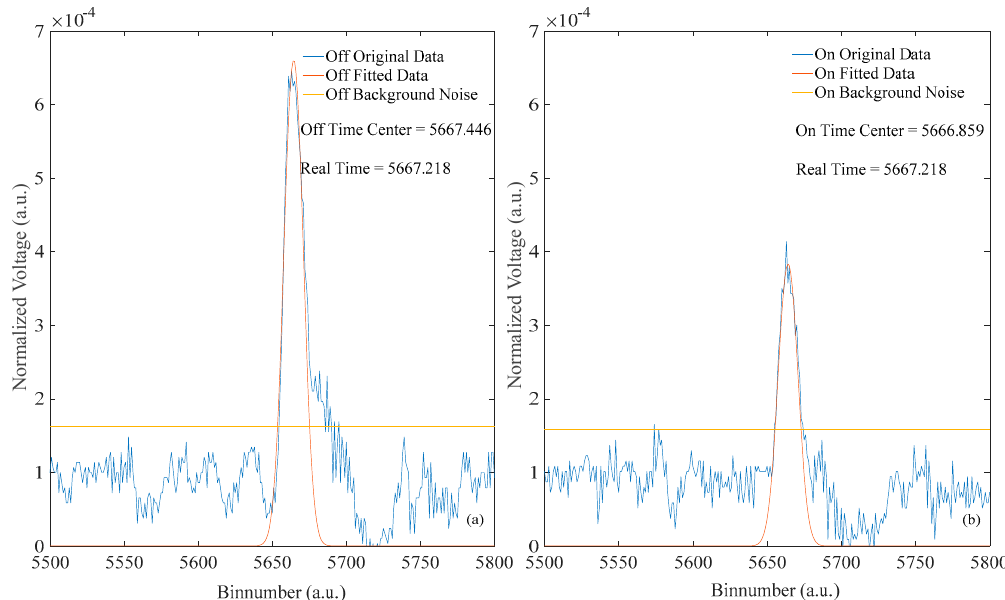
Figure 7. Waveform data processing results. ( a , b ) show the results of data processing in off-line and on-line, respectively. The off-line (on-line) time center represents the value after data processing and parameter optimization in the ( a ) or ( b ). Real-time represents the value after balancing the contradictory values of the dual-band time-center of gravity by introducing the error elimination theory.